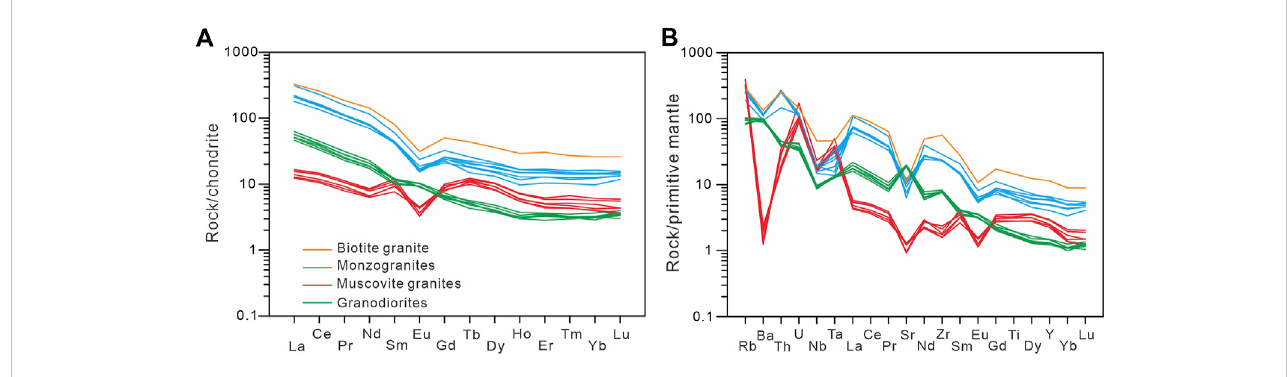
FIGURE 4 (A) Chondrite-normalized rare Earth elements (REE) diagram and (B) Primitive-mantle normalized trace element diagram for investigated Huatugou granitoids. Chondrite and Primitive-mantle reference values are from Sun and McDonough